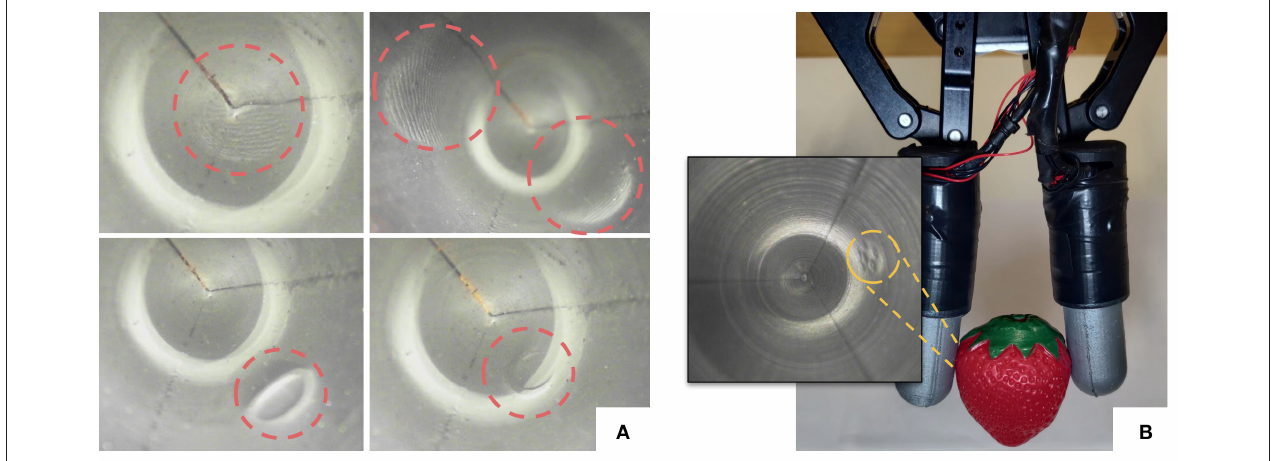
FIGURE 11 | (A) Tactile images captured using our proposed GelTip sensor. From left to right, top to bottom: a fingerprint pressed against the tip of the sensor, two fingerprints on the sides, an open-cylinder shape being pressed against the side of the sensor, and the same object being pressed against the corner of the tip, all highlighted in red circles. (B) A plastic strawberry being grasped by a parallel gripper equipped with two GelTip sensors, with the corresponding imprint highlighted in the obtained tactile image (in gray scale).